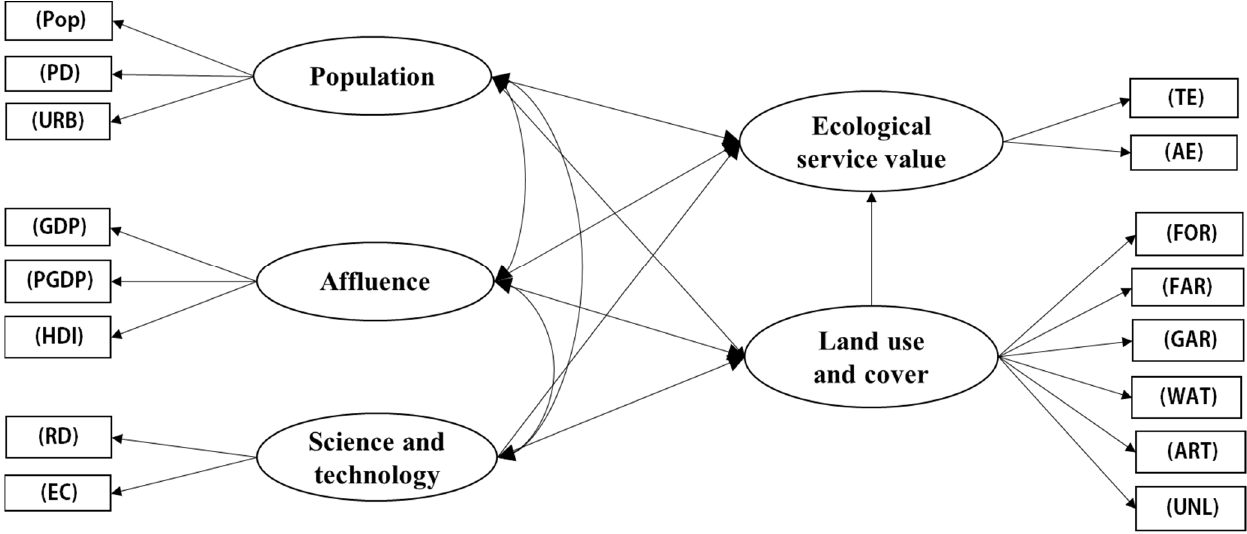
Figure 4. Path design of structural equation model.